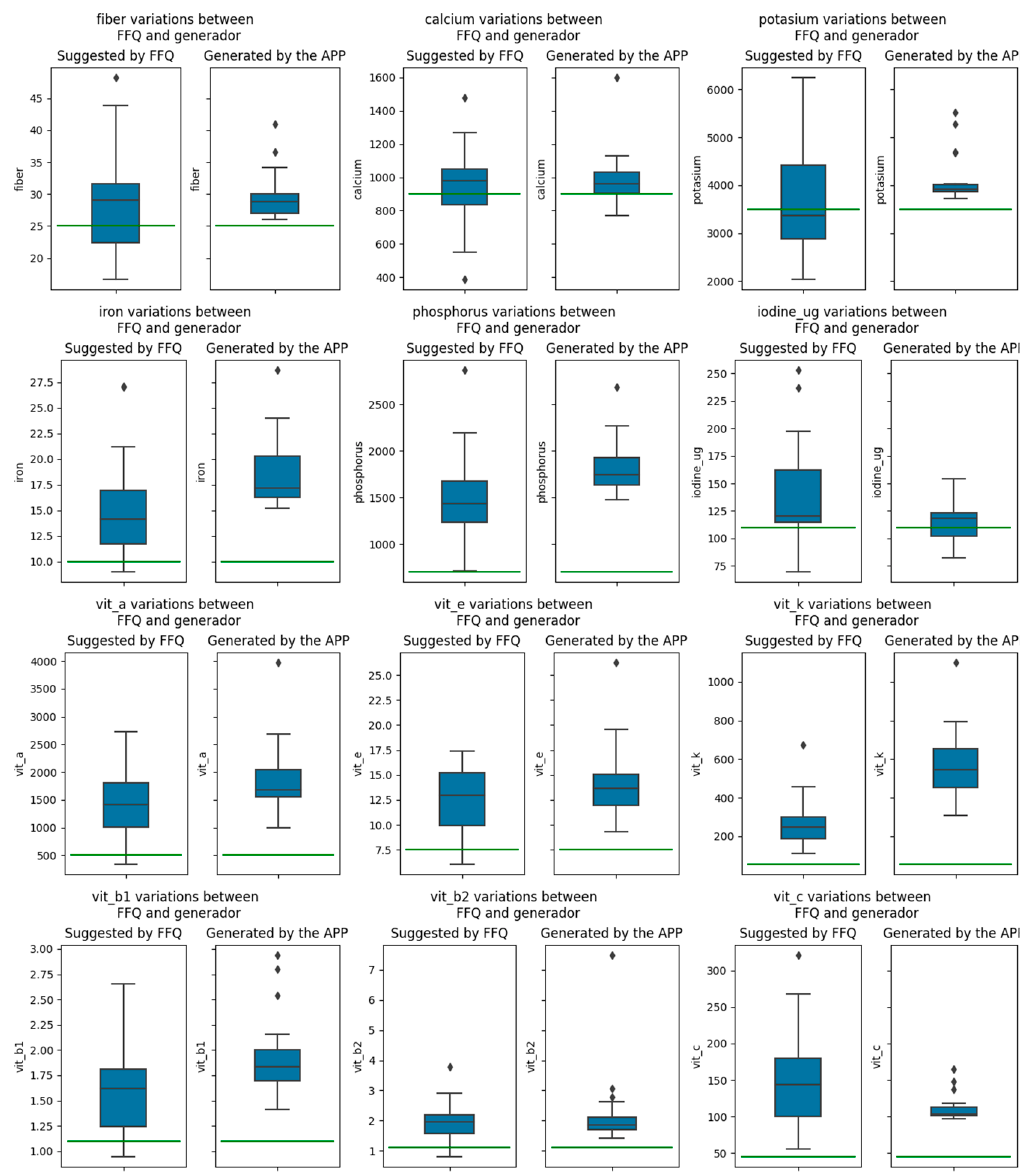
Figure 6. Energy and macronutrient comparisons from APP vs. FFQ. Green line specifies the inferior value of the DRVs.